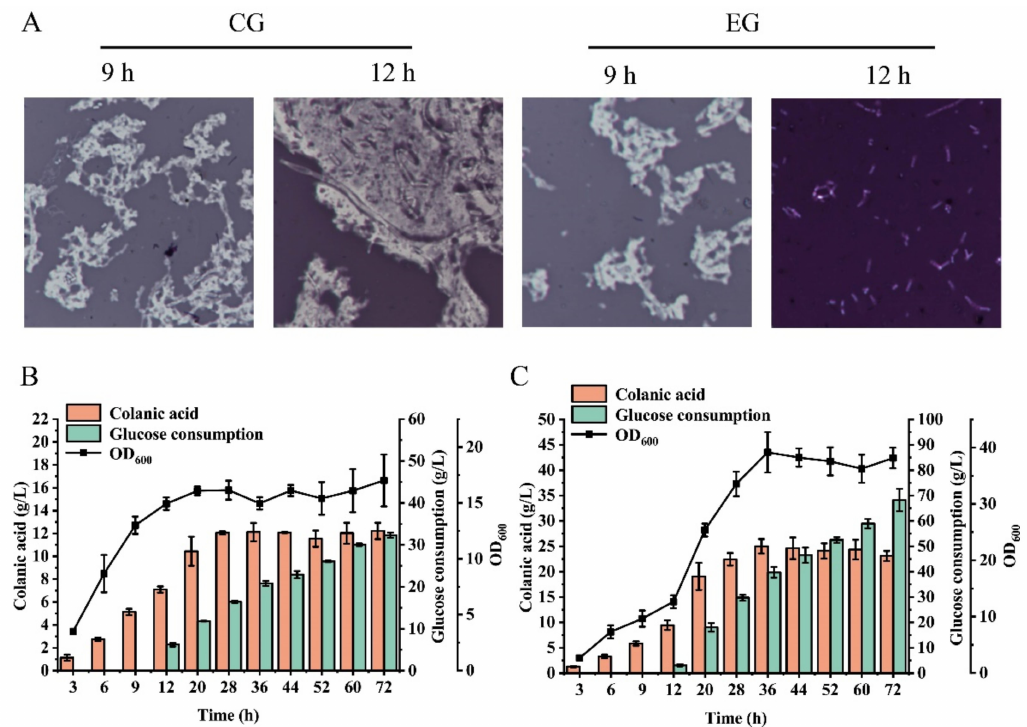
Figure 7. The influence of colanic acid hydrolase on colanic acid production on fed-batch. ( A ) The condition of the colanic acid capsule of SRP-4 strain on a 3-L bioreactor. A total of 4000 U/L colanic acid hydrolase was added to EG. CG, control group. EG, experimental group. ( B ) The colanic acid titer of SRP-4 on a 3-L bioreactor without adding the colanic acid hydrolase. ( C ) The colanic acid titer of SRP-4 on a 3-L bioreactor with 4000 U/L colanic acid hydrolase added. Both the CG and EG was supplemented glucose at 9 h and the glucose concentration was maintained between 9 and 12